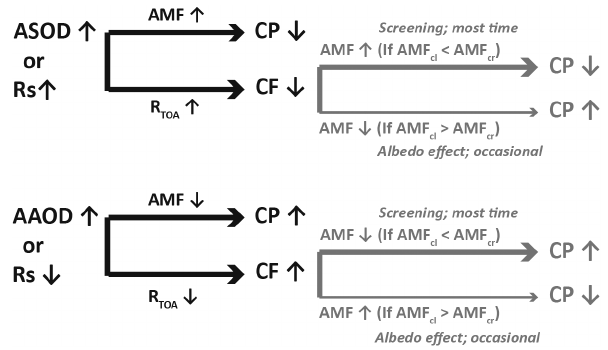
Figure 6. A diagram of how changes in surface reflectance (Rs), aerosol scattering (ASOD) and aerosol absorption (AAOD) affect the retrievals of CF and CP in the O 2 –O 2 algorithm. Grey colors illustrate the indirect influence of CF changes on the CP; the influ- ence depends on the “screening” or “albedo” effects of clouds on radiation. Thin grey lines indicate that the “albedo” effect of clouds is occasional. The figure is updated from Fig. 5 of Lin et al. (2014b).